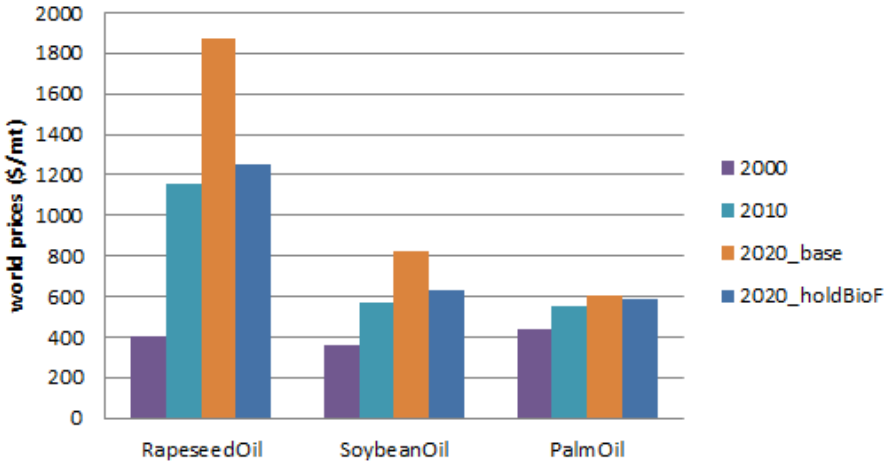
Figure 12. Biodiesel feedstock prices under baseline and